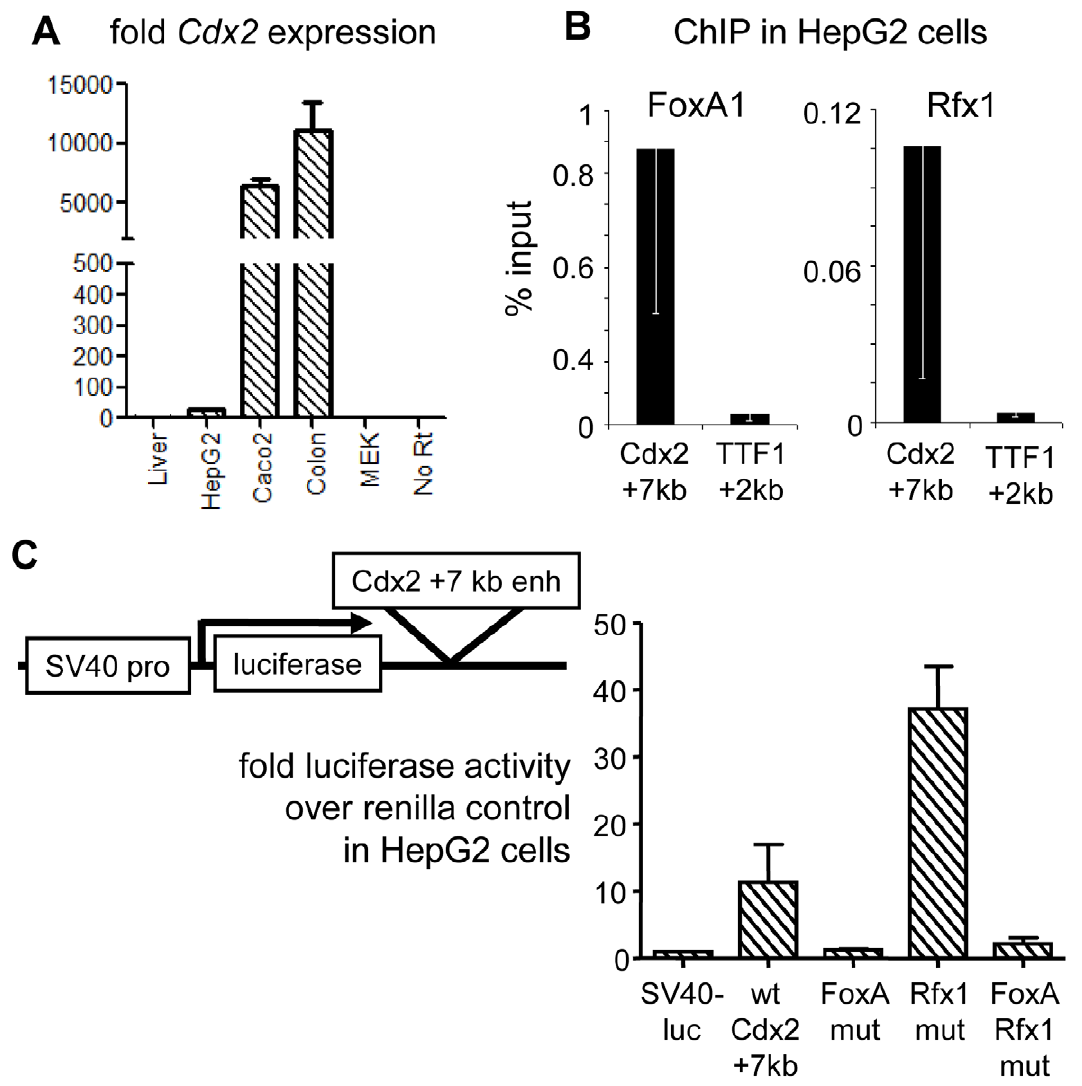
Figure 4. Genetic interactions at the Cdx2 + 7 kb enhancer. (A) Endogenous Cdx2 expression in mouse liver, HepG2 cells, Caco-2 cells, mouse colon and MEK cells, indicating the poor expression in HepG2 cells used for transfection. (B) ChIP for FoxA1 and Rfx1 in HepG2 cells comparing occupancy at Cdx2 + 7 kb and the negative control site TTF1 + 2 kb. (C) Dual-reporter luciferase assays using the Cdx2 element, with combinations of FoxA and Rfx1 site mutations. Cells were co-transfected with pRL-CMV-renilla and the indicated pGL3 reporter plasmids. Luciferase activity expressed as fold over the empty pGL3 vector after normalization to CMV-renilla in arbitrary units.